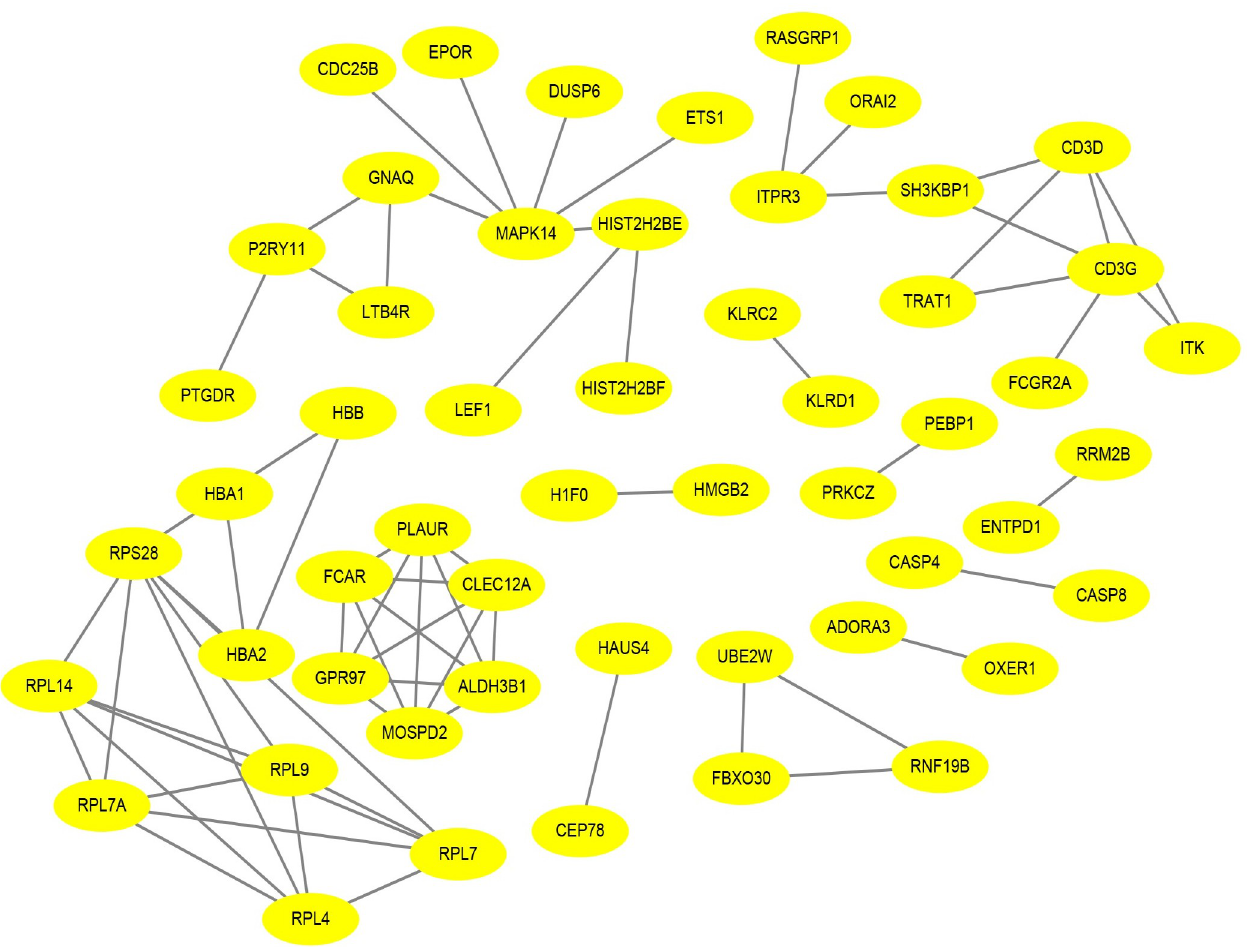
Fig 7. Male and female overlapping PPI network in epilepsy. The PPI network included 53 nodes and 68 edges.